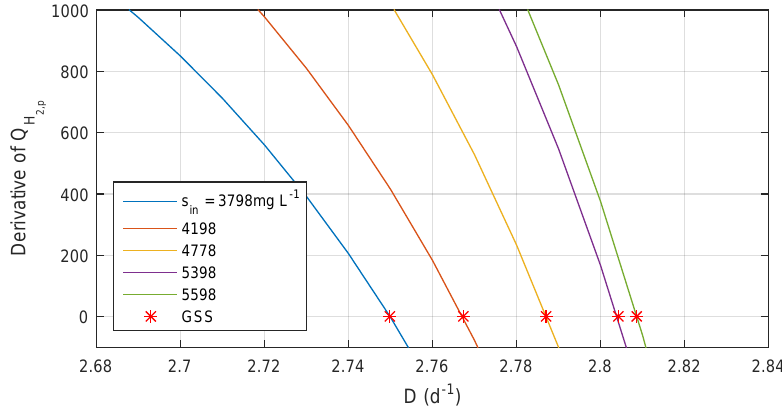
Figure 7. Derivative of Q H